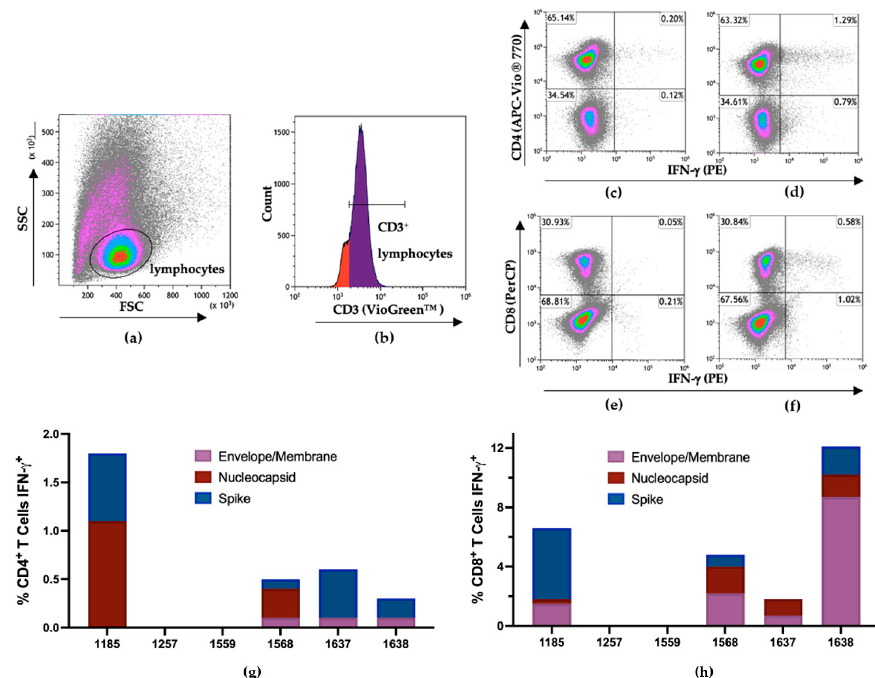
Figure 5. Flow cytometry gating strategy to discriminate SARS-CoV-2-specific CD4 + and CD8 + T cell responses. Following 7-day stimulation, cells were stained for extracellular CD3, CD4, and CD8 to discriminate T cell populations and for intracellular IFN- γ to identify SARS-CoV-2-specific T cells. ( a ) Gating on lymphocytes following 7-day in vitro stimulation. ( b ) Gating on CD3 + lymphocytes. ( c ) Non-restimulated CD4 + IFN- γ + cells and ( d ) CD4 + IFN- γ + cells after 5 h stimulation with SARS-CoV-2 N protein peptide pool. ( e ) Non-restimulated CD8 + IFN- γ + cells and ( f ) CD8 + IFN- γ + cells after 5 h stimulation with SARS-CoV-2 S protein peptide pool. Data were analyzed and visualized using Kaluza Version 2.1 (Beckman Coulter). Total percentages of the ( g ) CD4 + and ( h ) CD8 + T cell populations responding to SARS-CoV-2 protein peptide pools with IFN- γ production after 7-day in vitro stimulation.